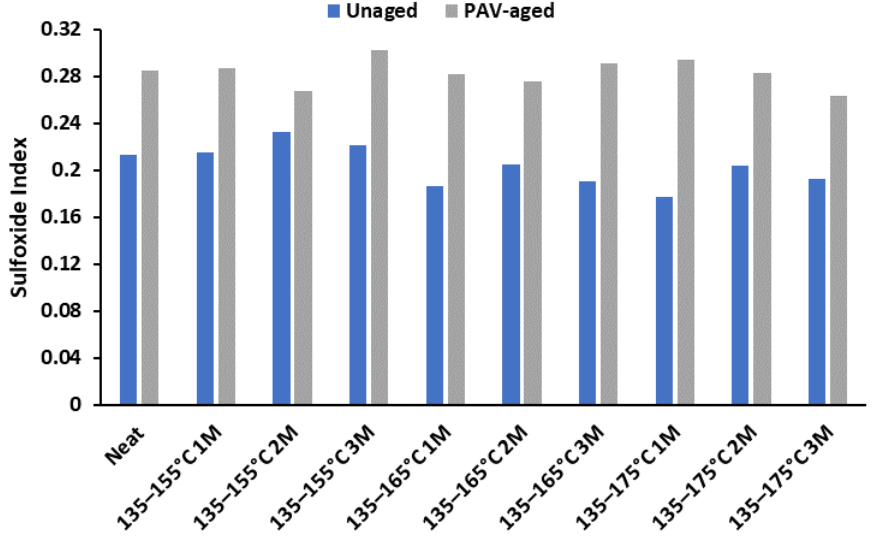
Figure 19. Sulfoxide index results at the unaged and PAV-aged stages.